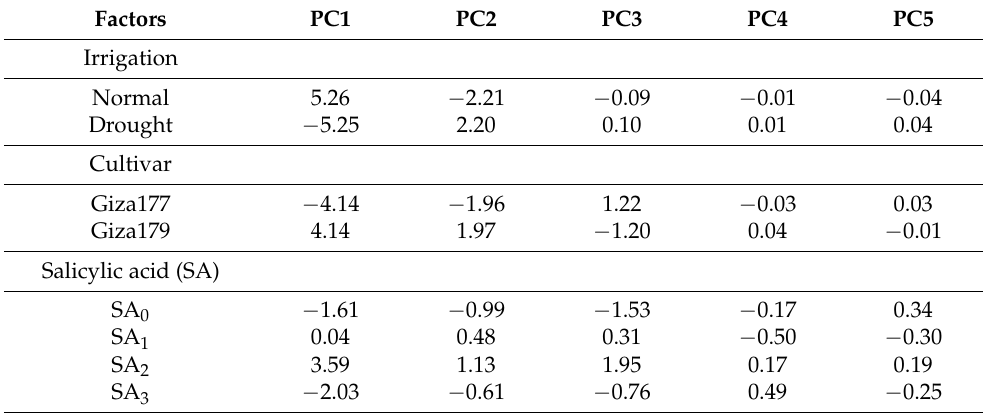
Table 9. Results of principal component analyses (PCAs) for the studied factors based on the studied traits during the normal and drought stress conditions.